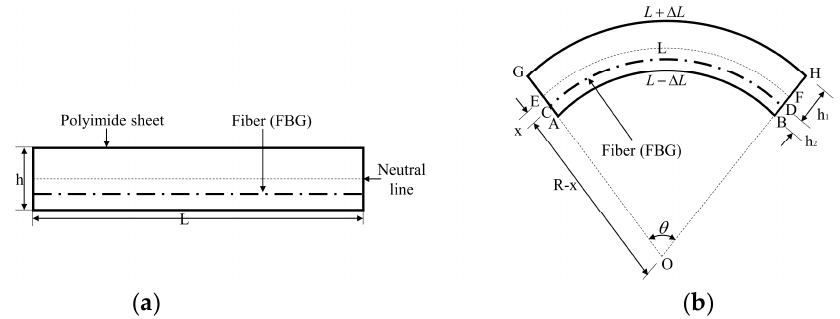
Figure 2. Sensing theory of the polyimide FBG sensor. ( a ) Free-state without bending and ( b ) bending